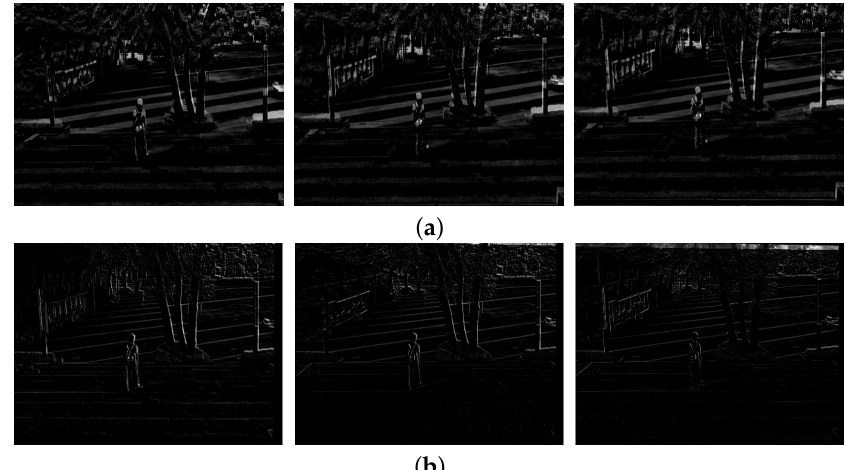
Figure 8. Experimental results of the video stabilization method: ( a ) differences of the original video (80th, 81st, and 82nd frames) and ( b ) the stabilized video (80th, 81st, and 82nd